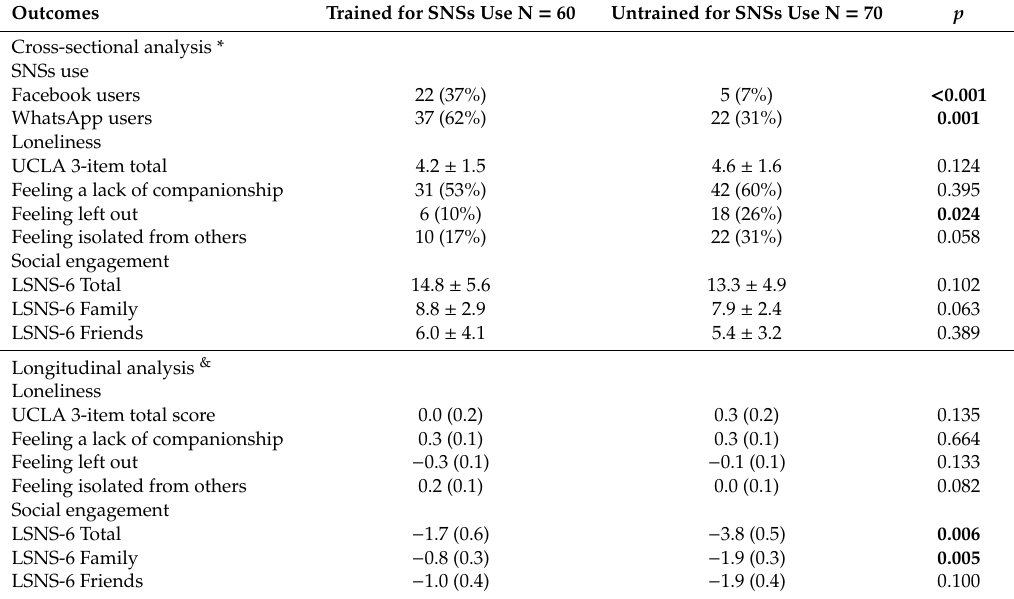
Table 2. Di ff erences between older adults trained and untrained for Social Networking Sites (SNSs) use on SNSs use, loneliness, and social engagement during the COVID-19 lockdown and impact of SNSs training course on one-year changes in loneliness and social engagement. Outcomes Trained for SNSs Use N = 60 Untrained for SNSs Use N = 70